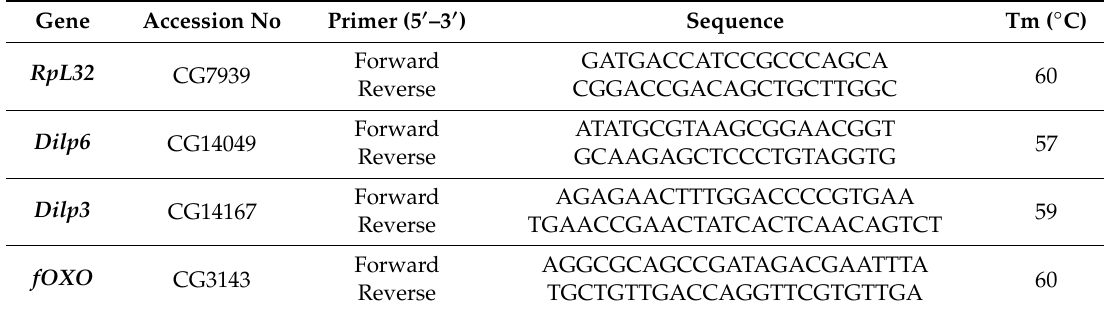
Table 1. Primers and their sequences used in quantitative RT-PCR